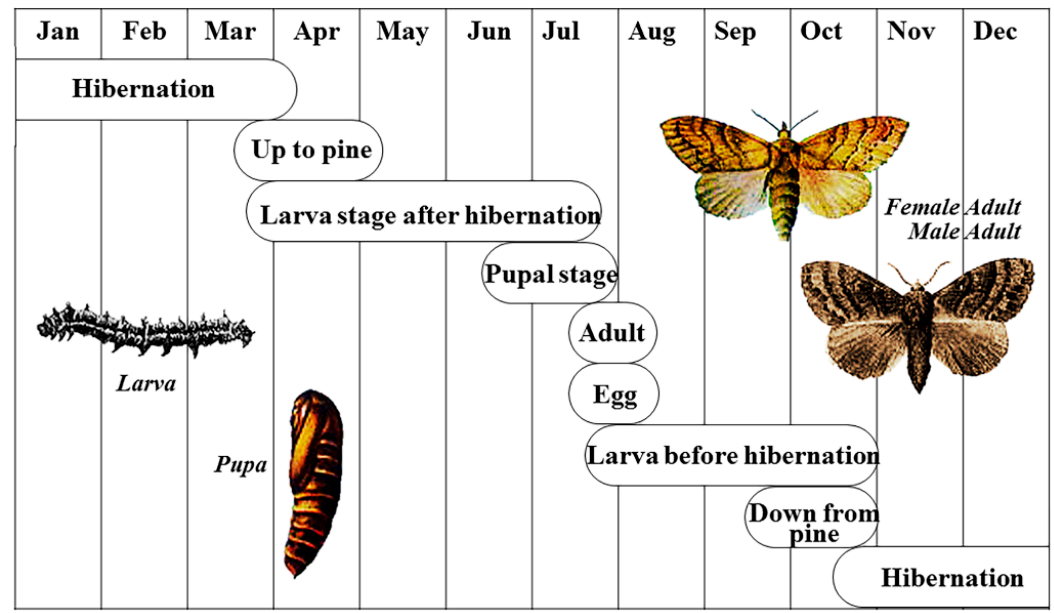
Figure 2. Life history of the pine caterpillar, D. tabulaeformis.